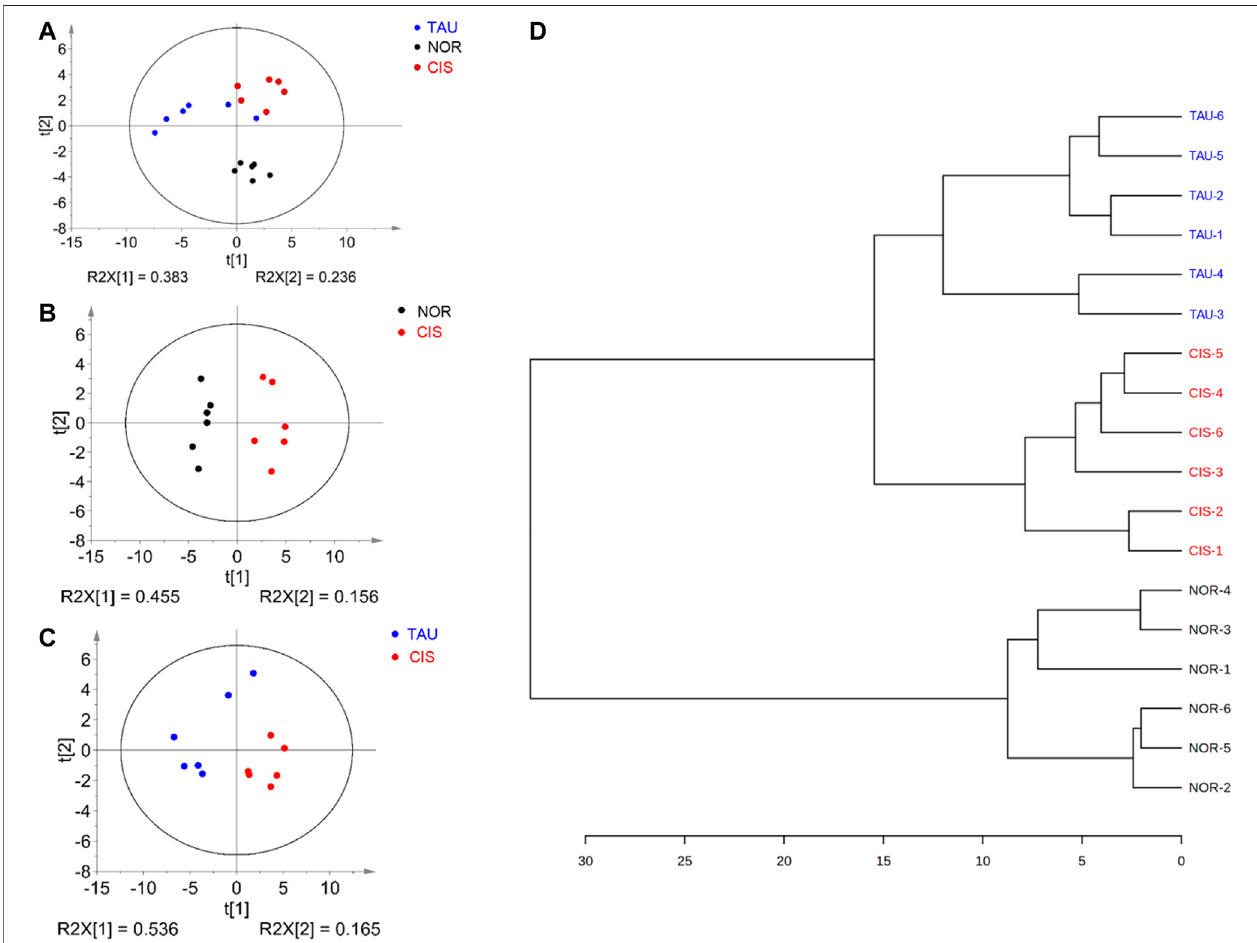
FIGURE 5 | Pattern recognition analysis for the 1D 1 H NMR spectra recorded on aqueous extracts derived from the three groups of C2C12 myoblasts. (A) PCA score plot of the three groups of cells. (B, C) PCA score plots for CIS vs. NOR (B) and TAU vs. CIS (C) . The ellipses indicate the 95% con fi dence limits. (D) Hierarchical cluster analysis for the three groups of